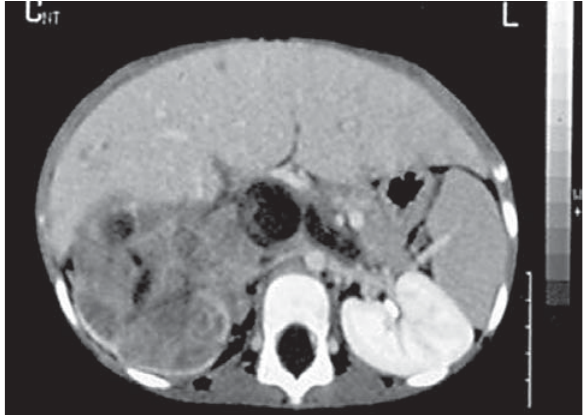
Figure 1 – CT scan revealing thrombus in the vena cava in a patient with Wilms’